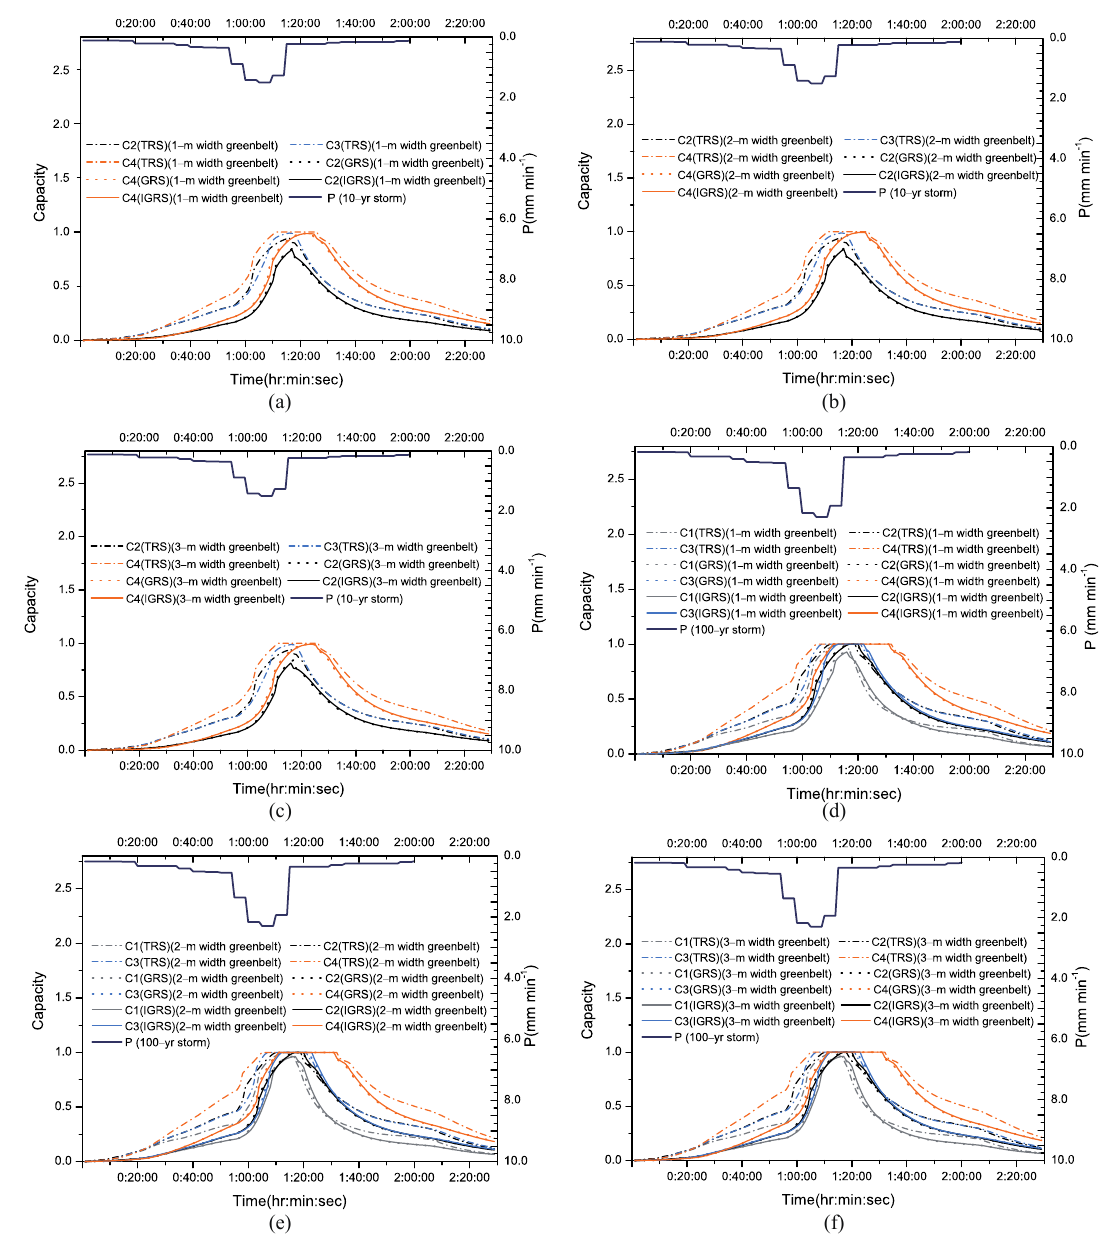
Figure 13. Comparison of the overload conduits among the GRS, IGRS, and TRS for 2 single precipitation events (10-yr and 100-yr). ( a ) 10-yr storm (1-m width greenbelt); ( b ) 10-yr storm (2-m width greenbelt); ( c ) 10-yr storm (3-m width greenbelt); ( d ) 100-yr storm (1-m width greenbelt); ( e ) 100-yr storm (2-m width greenbelt); ( f ) 100-yr storm (3-m width greenbelt). 537 Table 8. Comparison of the flooding flow among the GRS, IGRS, and TRS in the single event 538 simulation. 539